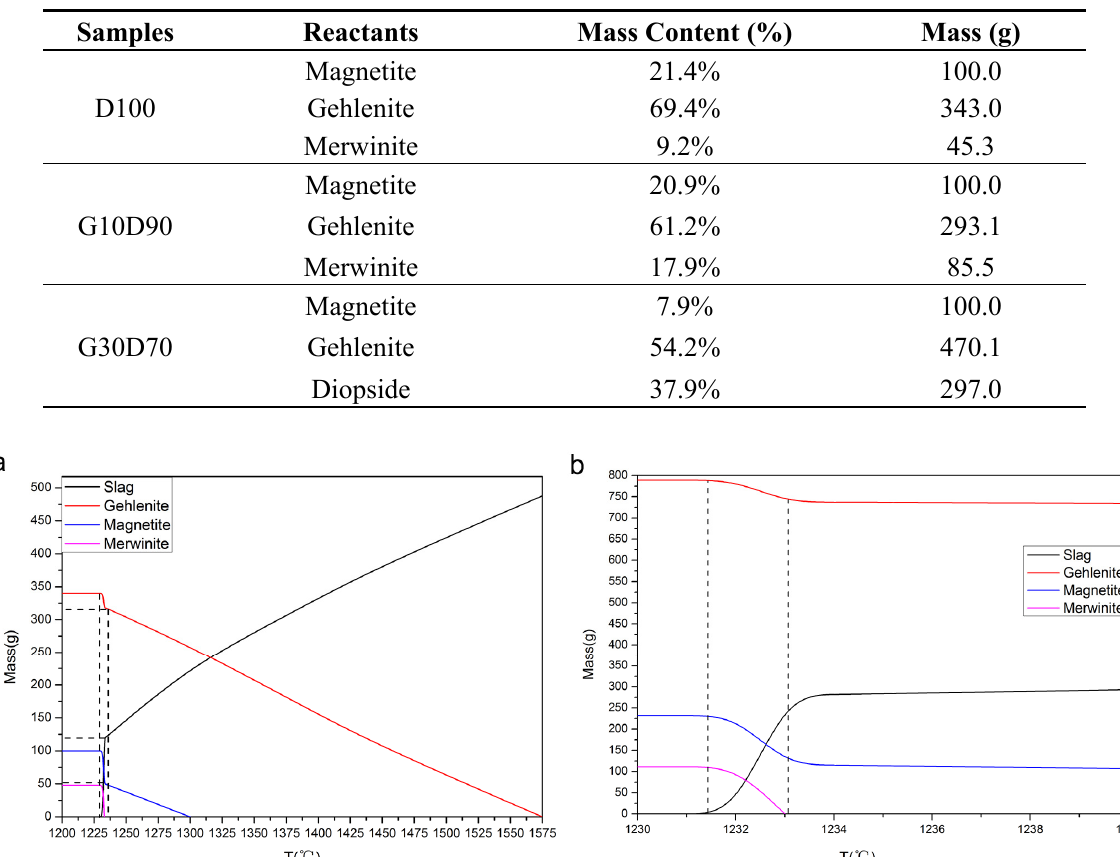
Table 4. Relative mass content of the eutectic reactants (mass of Magnetite: 100 g).